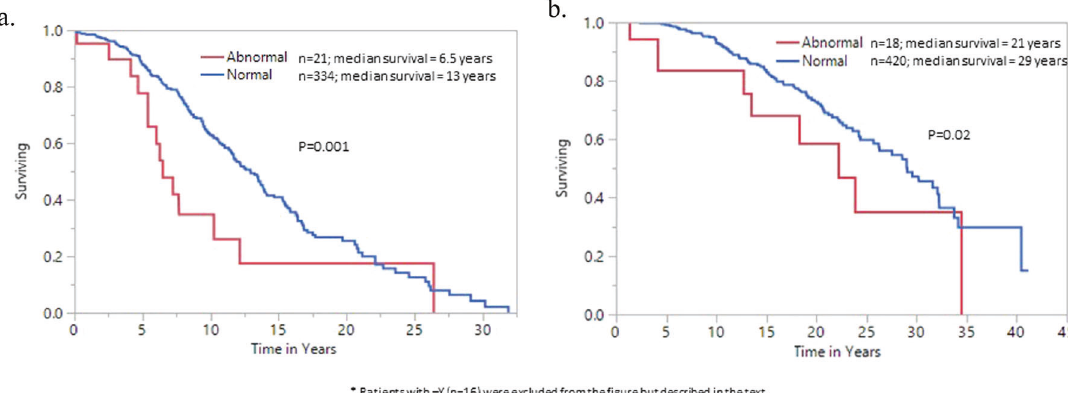
Fig. 1 Overall survival and karyotype in essential thrombocythemia. a Overall survival of 355 patients of age> 60 years with essential thrombocythemia, strati fi ed by abnormal vs normal karyotype. b Overall survival of 438 patients of age < 60 years with essential thrombocythemia, strati fi ed by abnormal vs normal karyotype.